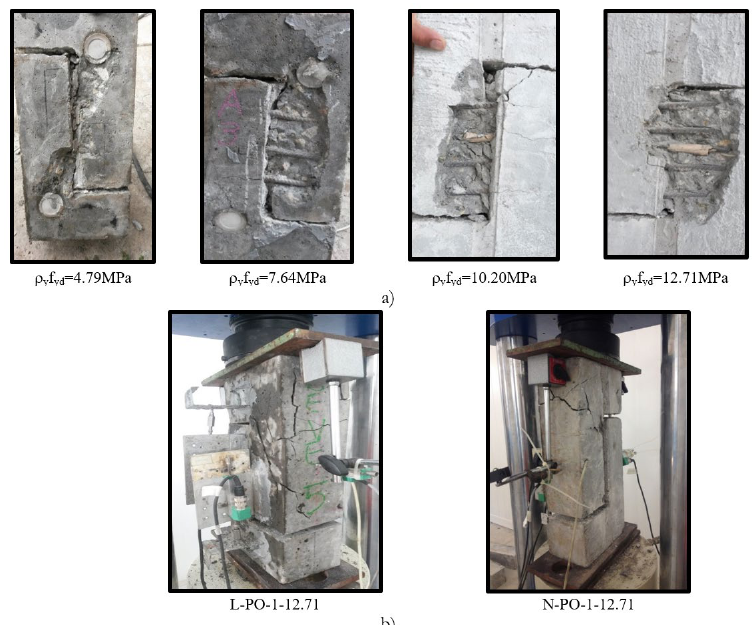
Figure 8. Modes of shear failure of push-off specimens: a) shear plane failure, b) bending and shear combination failure